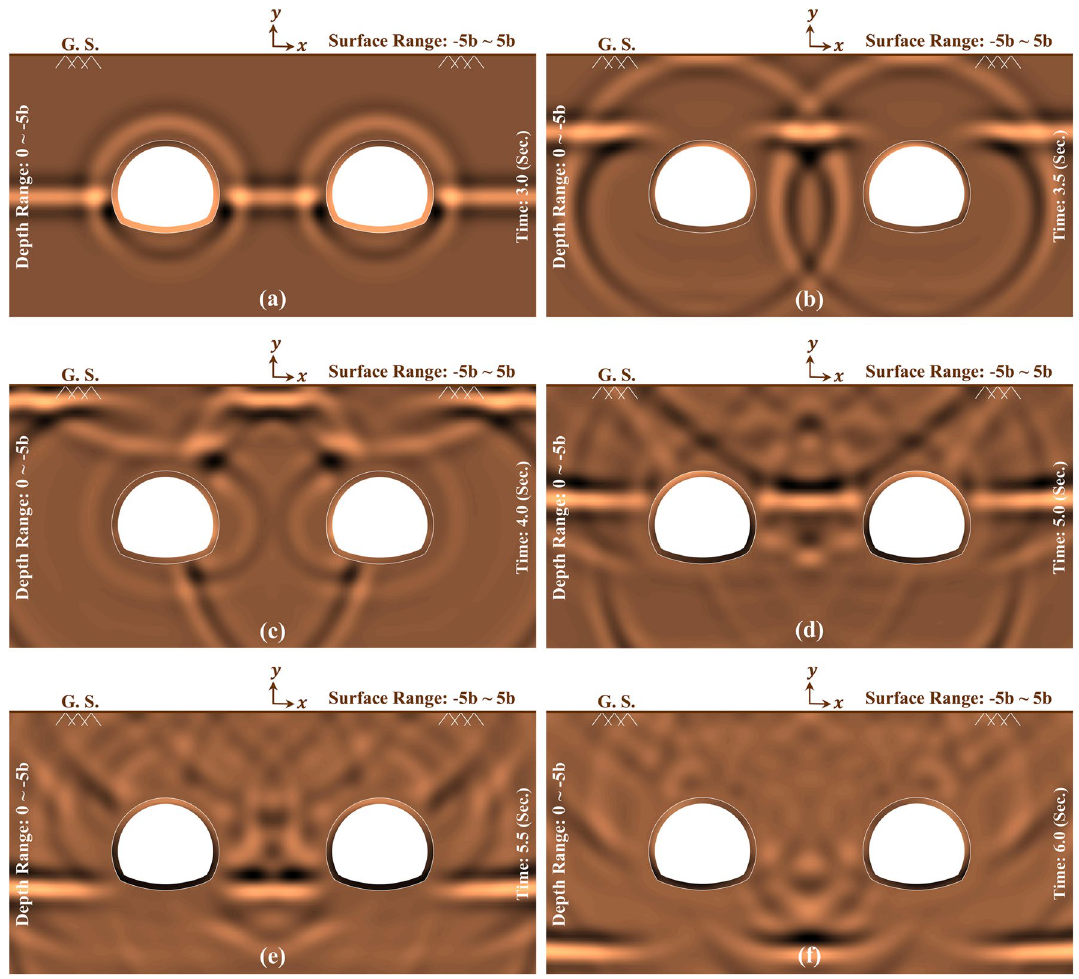
Fig. 7 Wave propagation snapshots and the procedure of the SH waves’ dispersion below the ground surface, for the model of twin horse- shoe-shaped lined tunnels subjected to vertical incident